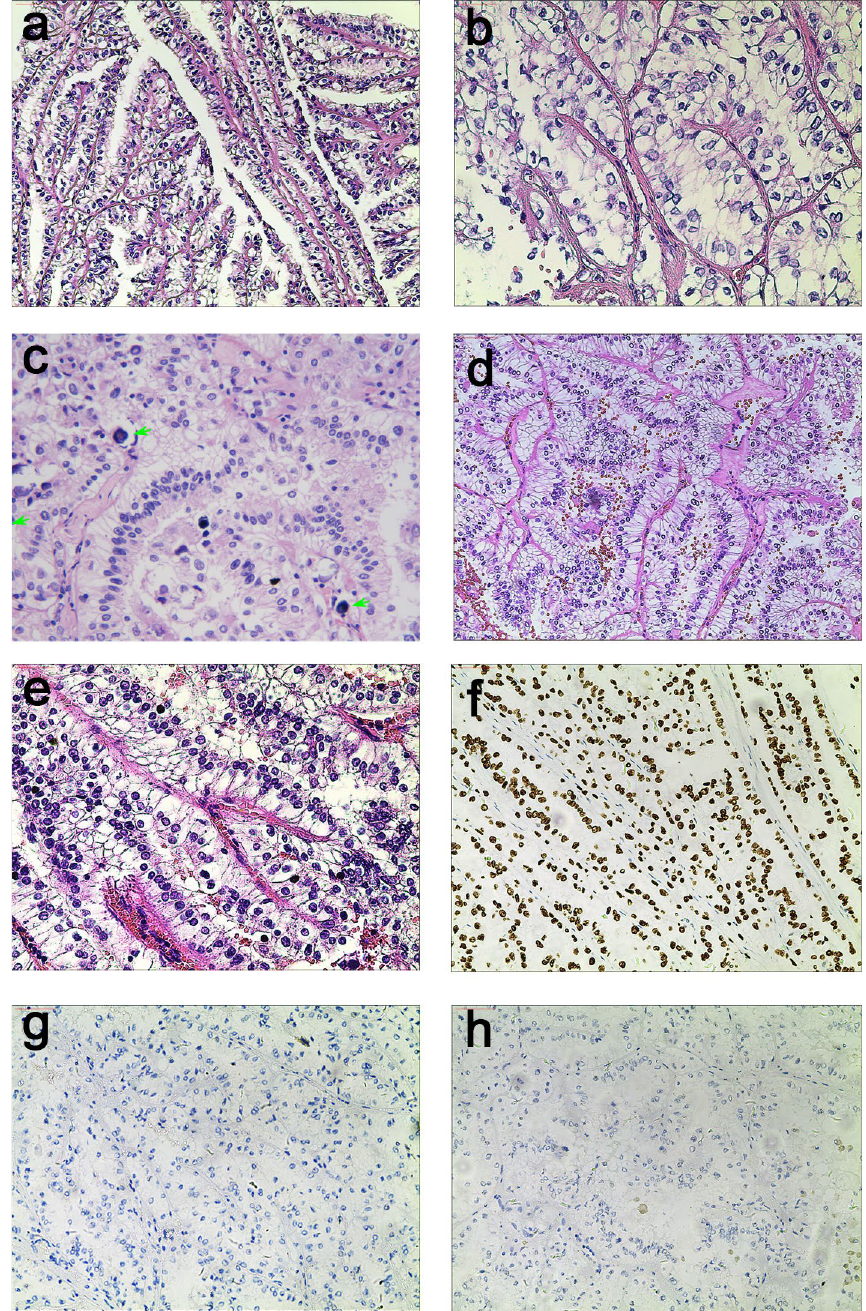
Figure 7. The typical morphologically and IHC feature of NONO-TFE3 RCC. ( a – c ) In cases 1, tumor have predominantly papillary architecture, which features epithelioid cells with clear to finely granular eosinophilic cytoplasm. The neoplastic abundant clear cytoplasm, and nuclei were oriented toward the luminal surface and were round and uniform in shape, resulting in the appearance of secretory endometrioid subnuclear vacuolization. Focal psammoma bodies were also observed (arrows). ( d , e ) In cases 4, tumor have predominantly nested to papillary architecture, The neoplastic cells lined with high columnar cells with distinct cell borders, a flocculent eosinophilic cytoplasm, and WHO/ISUP grade 2 nuclei; ( f ) the neoplastic cells demonstrate moderate nuclear labeling for TFE3; ( g ) the neoplastic cells demonstrate negative labeling for CA-IX; ( h ) the neoplastic cells demonstrate negative labeling for